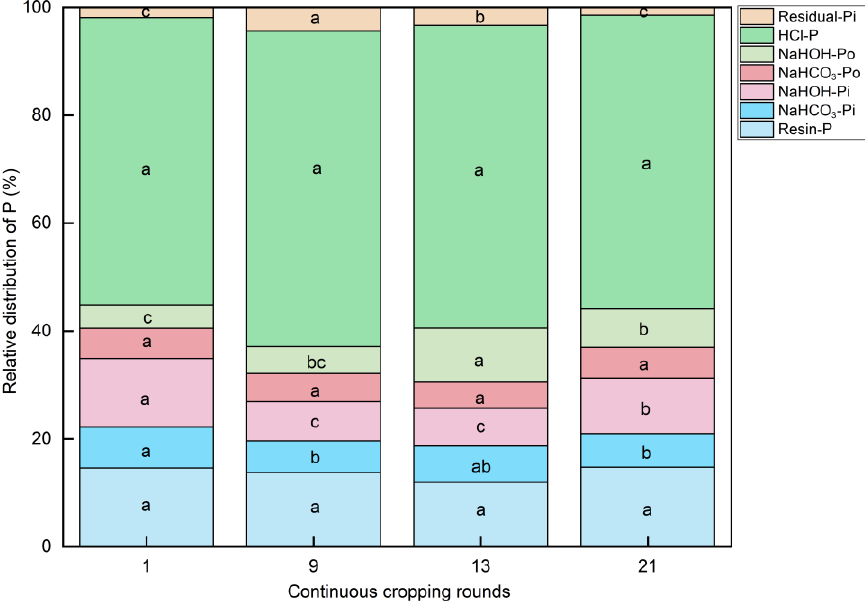
Figure 4. The relative distribution of P fraction in 0–20 cm soil under long-term continuous cropping. The different letters indicate the significant differences among the treatments on p < 0.05.